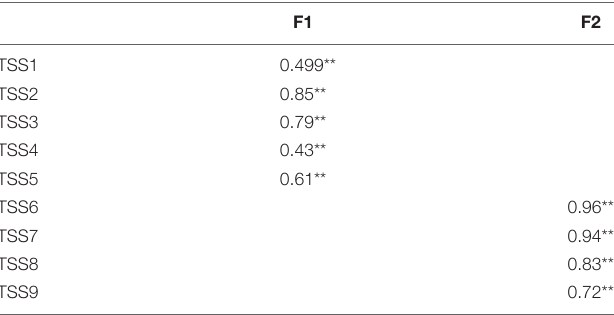
TABLE 5 | Factor loadings for the TSS as identified by the original 2-factor CFA